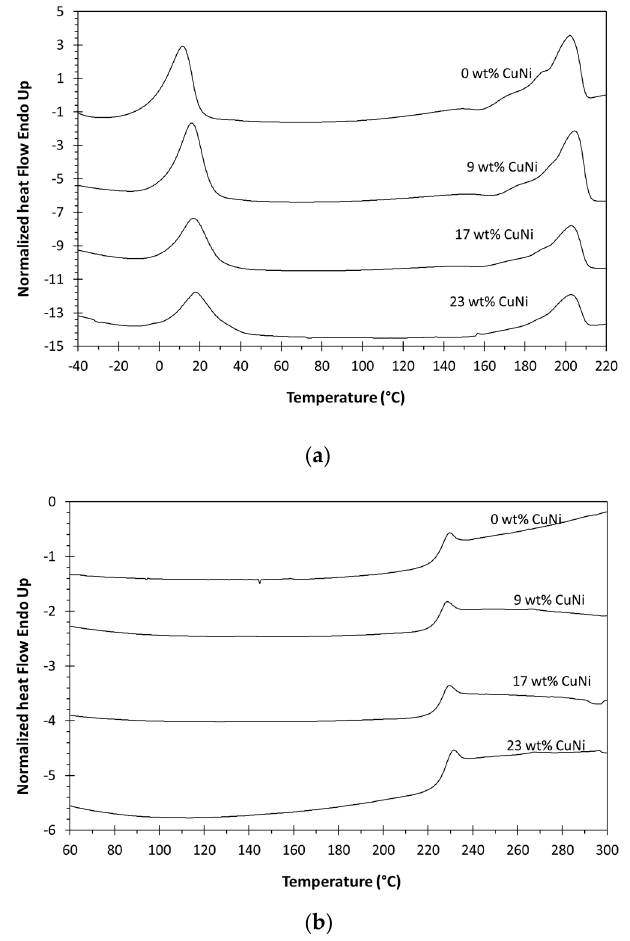
Figure 4. DSC thermograms for the membrane of ( a ) neat Pebax1657 and ( b ) neat PEEK-WC and MMMs with different concentration of CuNi-MOF during the second eating.